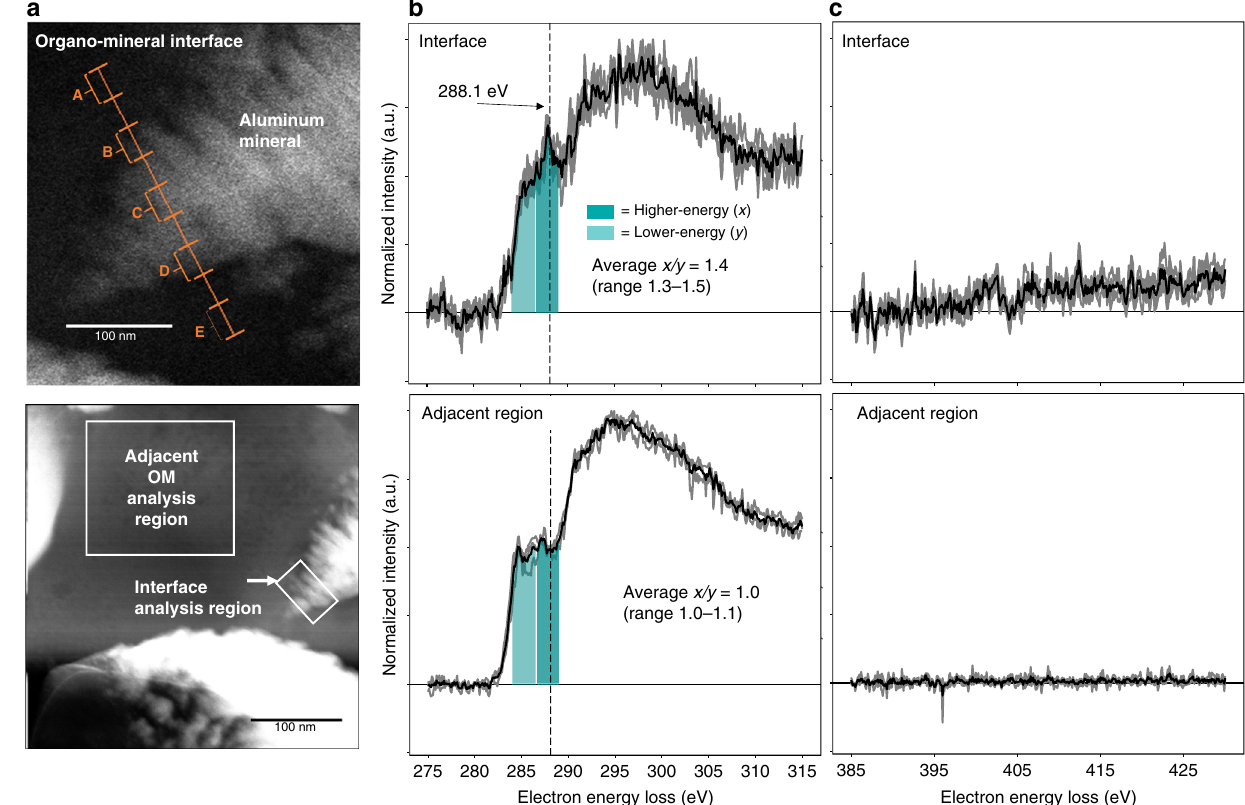
Fig. 2 Nitrogen and oxidized carbon enrichment at the organo – mineral interface. High-resolution cryo-electron imaging and spectroscopy of an organo – mineral interface in a volcanic soil sample. a Annular dark- fi eld (ADF) scanning transmission electron microscopy (STEM) image of organo – mineral interface and adjacent organic matter region, showing the location of electron energy-loss spectroscopy (EELS) data collection across and adjacent to an aluminum (Al) mineral with layered structure. b , c Average carbon ( b ) and nitrogen ( c ) K-edge EELS (black line) and individual spectra (gray lines) for either fi ve points (A – E) across the organo – mineral interface or three EELS point scans within the adjacent OM region. For both b and c , spectra are shown unsmoothed and normalized to the maximum carbon intensity. In b , dotted vertical line indicates peak at 288.1 eV, putatively identi fi ed as carboxylic/carbonyl groups with substituted or adjacent N 31,32 . Lower (284.0 – 286.5 eV) ( y ) and higher (286.6 – 289.0eV) ( x ) energy regions are indicated by shaded boxes. Ratio x / y indicates the ratio of integrated EELS intensity within each region, normalized to total carbon integrated area (280.0 – 315.0 eV). Between the adjacent region and interface, the x / y ratio increased by an average 33% (Supplementary Table 2), indicating an increase in oxidized C at the organo – mineral interface compared to the adjacent C region. In addition, the ratio of integrated total carbon (280.0 – 315.0 eV) to total nitrogen (395.0 – 430.0 eV) decreased by an average 88% between the adjacent C region and the organo – mineral interface